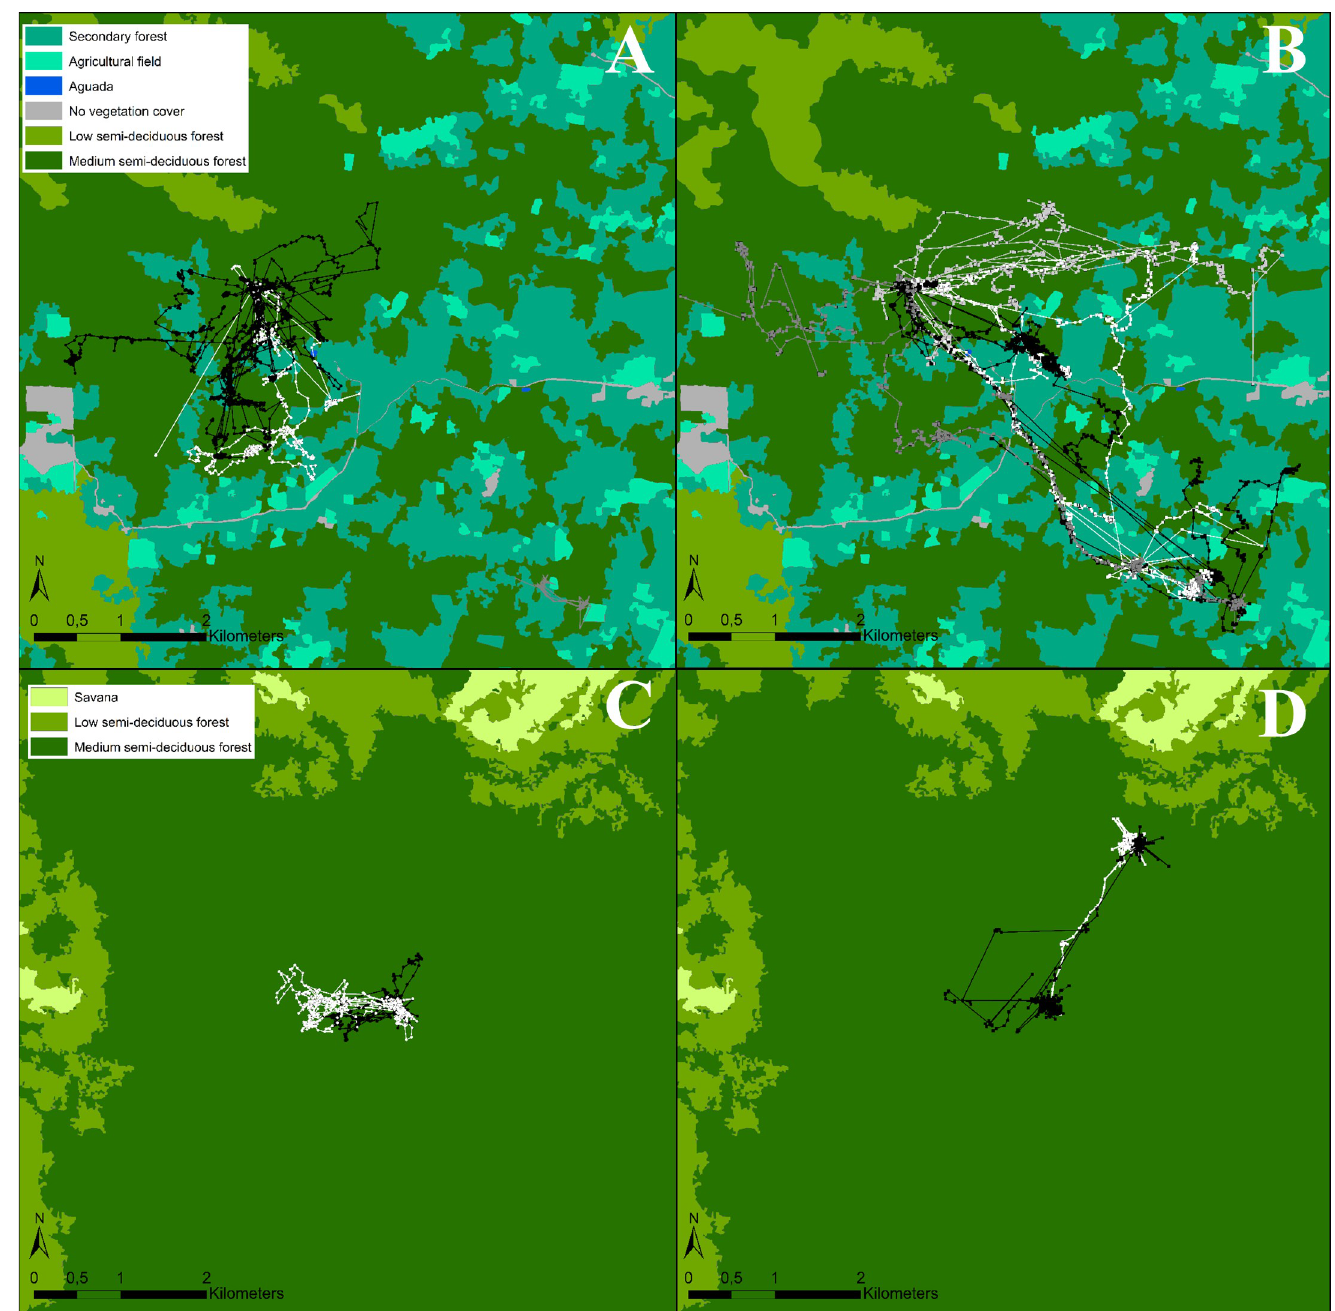
Fig 1. The total recorded night flight paths of two females (A) and four males (B) in the study site of Hormiguero and two female (C) and two males (D) in the study site of Monterrey. Different colors depict different individuals.